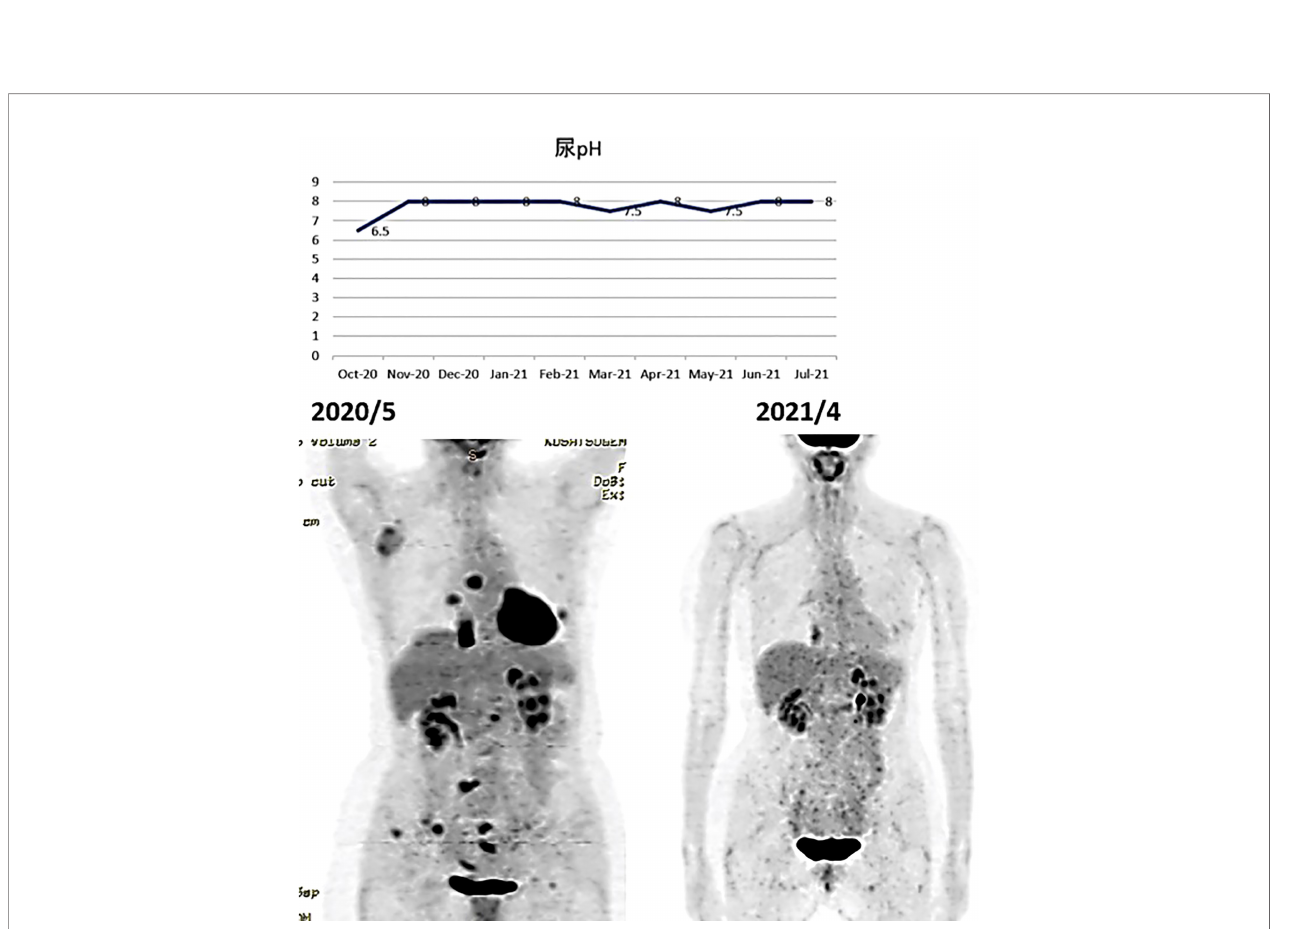
FIGURE 11 | (Upper) Her urine pH levels are shown. (Lower) A PET/CT scan showed that tumor had